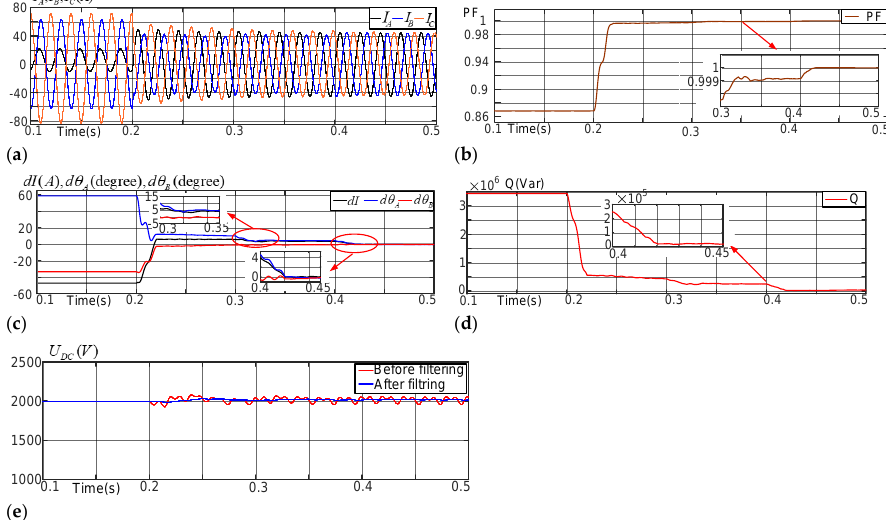
Figure 9. A simple PI controller that compensates for RPC.